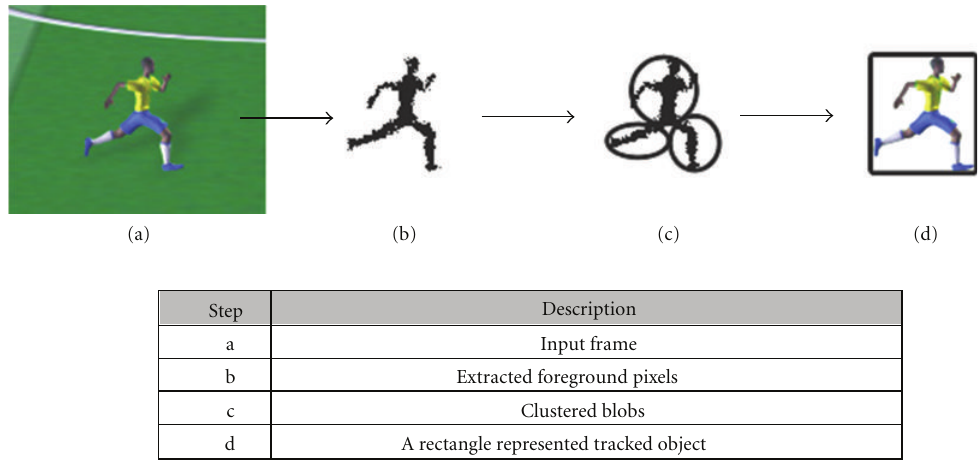
Figure 4: Steps of creating the object from by background subtraction